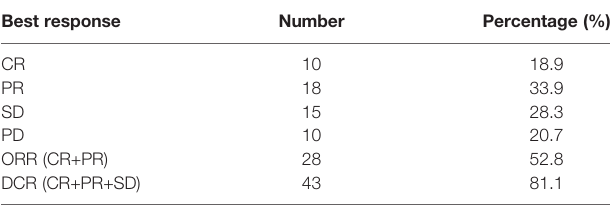
TABLE 2 | Radiological response according to mRECIST and clinical ef fi